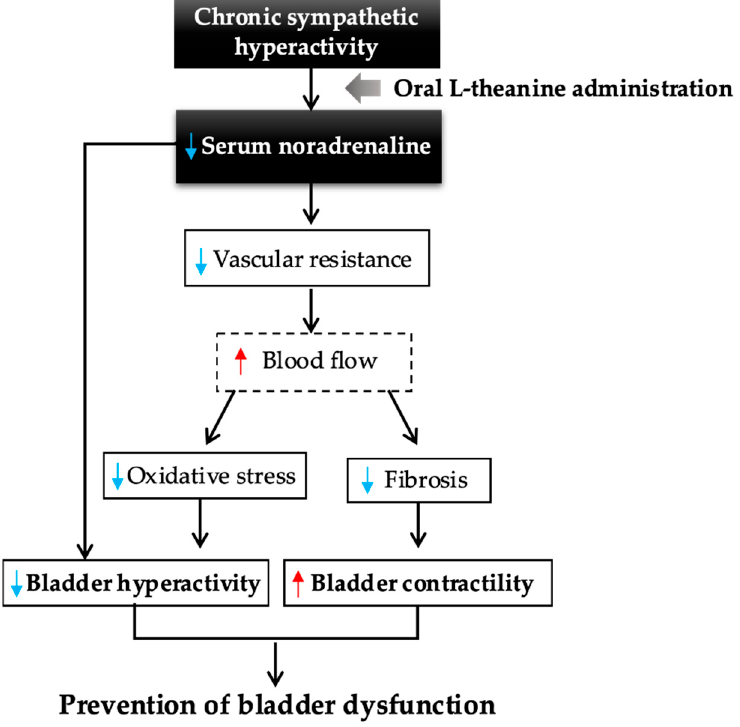
Figure 8. Summary of a potential hypothesized pathway for preventive effects of L -theanine on bladder dysfunction. Decreased serum noradrenaline level by L -theanine administration directly prevents bladder dysfunction with bladder hyperactivity. As an indirect pathway, decreased vascular resistance inhibits the increase in oxidative stress and fibrosis associated with bladder ischemia, resulting in suppression of bladder hyperactivity and prevention of impaired bladder contractility.